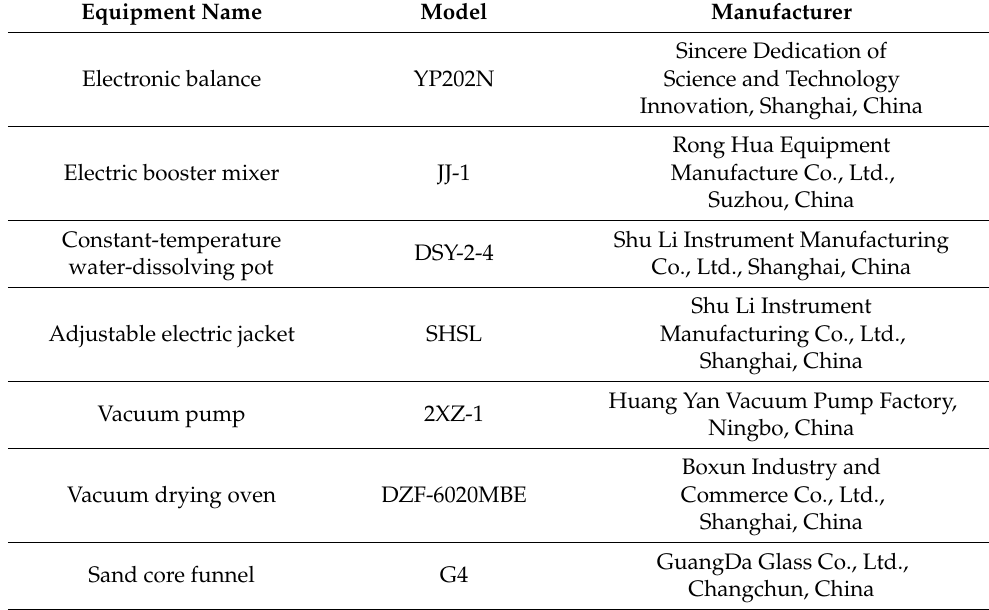
Table 1. Experimental equipment used in this